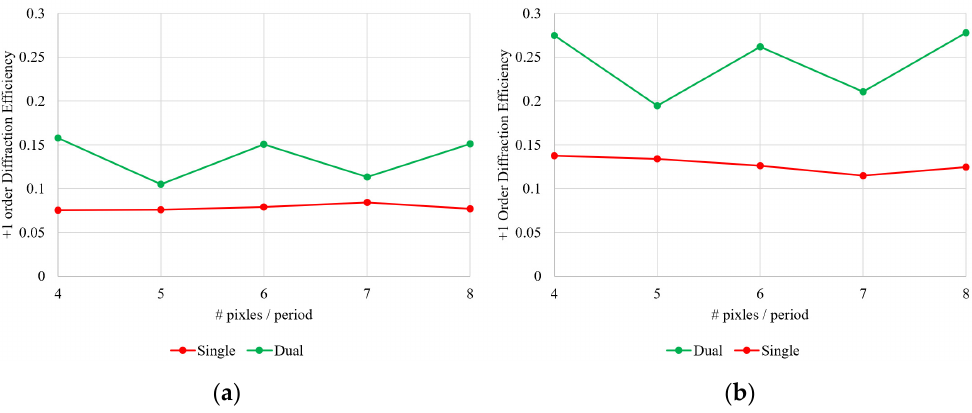
Figure 5. A +1st order diffraction efficiency as a function of the number of pixels/periods between the ( a ) binary- and ( b ) staircase-approximated blazed grating. The spacing between the mirror (M1) and the MEMS-PLM is set to the Talbot distance, which supports grating period of 4, 6, and 8 pixels.